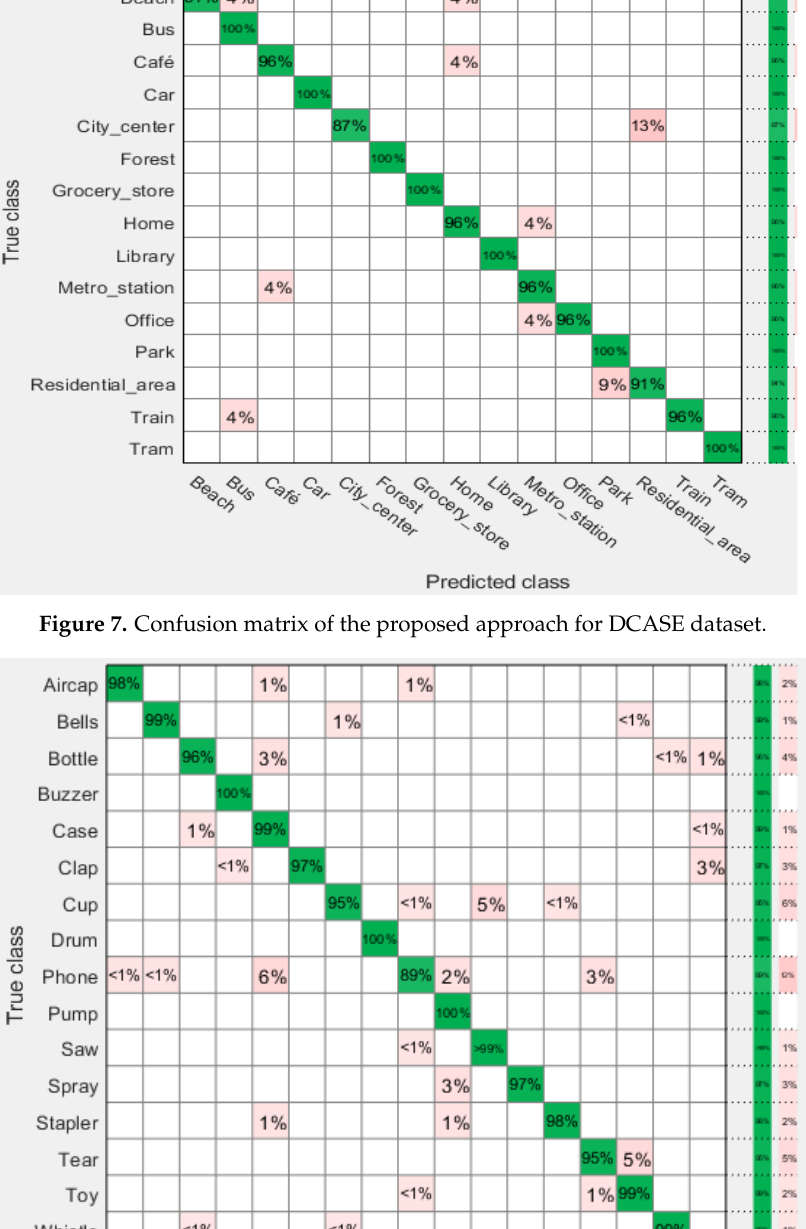
Table 1: Accuracy (%) of classification over DCASE and RWCP datasets